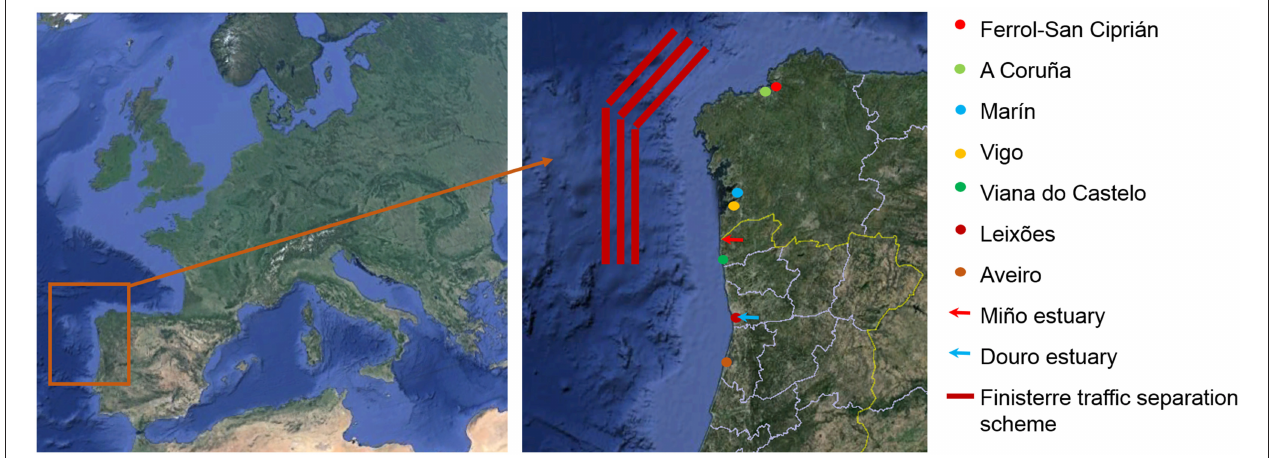
FIGURE 2 | RAIA Observatory region of action and main ports (dots), rivers (arrows), and traffic separation scheme (red lines) (Otero et al.,